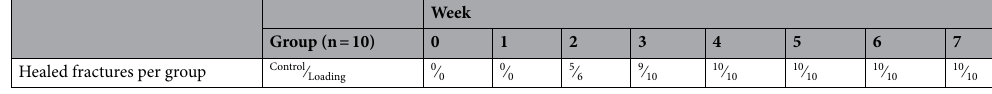
Table 1. Fracture healing outcome assessed by cortical bridging (healed fracture ≥ 3 bridged cortices, threshold 395 mg HA/cm 3